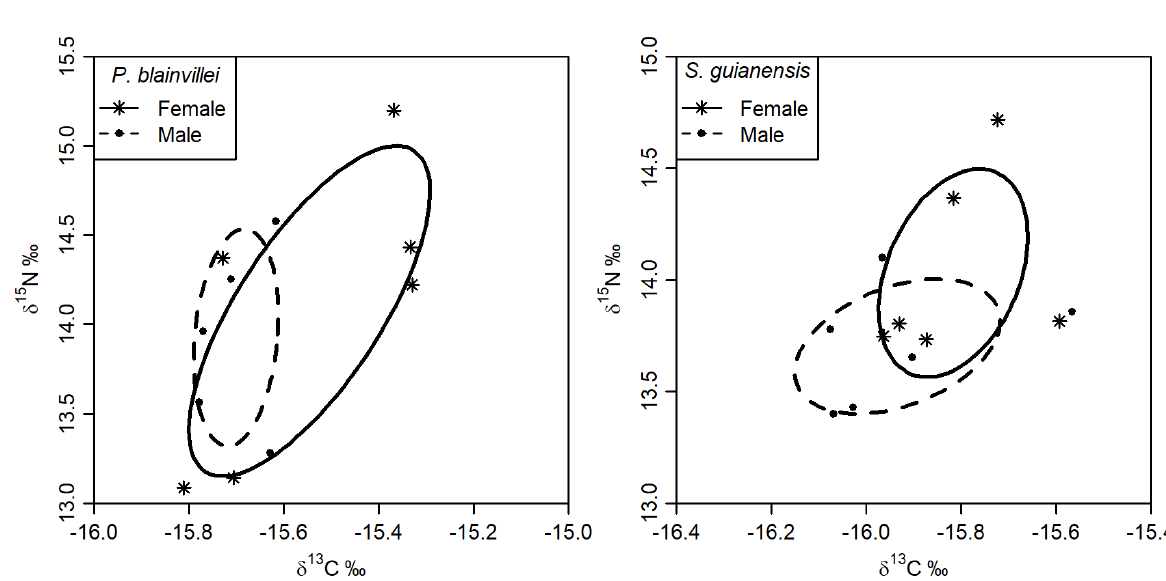
Figure 4. Scatter plot of the δ 13 C and δ 15 N values (δ-space) of the sex classes of franciscana dolphins (left) and coastal Guiana dolphins (right). Each dot represents an individual and each ellipse represents 40% of the samples of each species using the SEAc